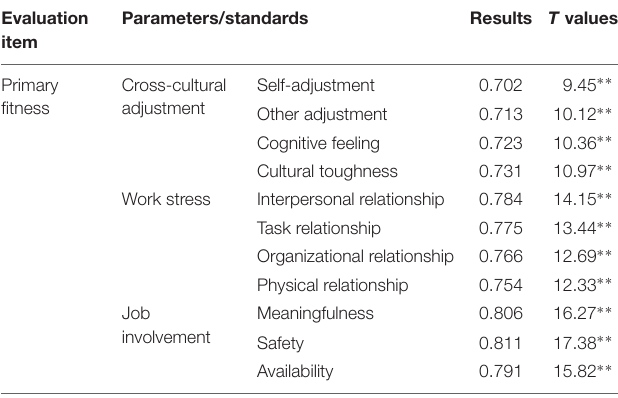
TABLE 3 | Analysis results of the overall linear structural relation (LSR) model.